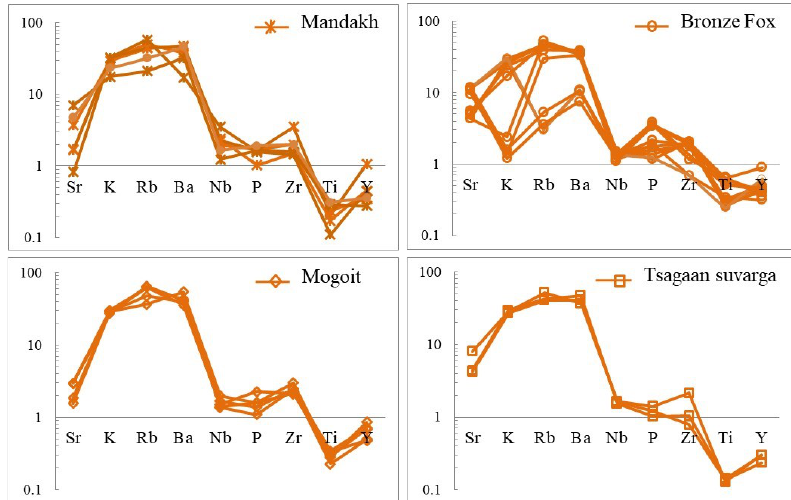
Figure 6. Spider diagram for the samples of plutonic rocks from the Mandakh area. Trace element values are normalized to MORB (Pearce and Cann, 1973)